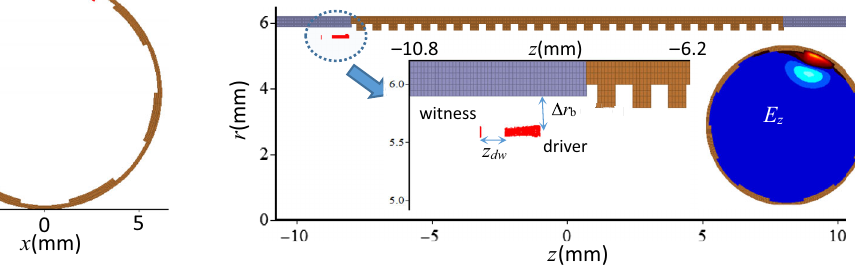
FIG. 1. (a) 3D model basic cell of the 2D periodic surface lattice generated using CST MW S tudio with the period of the lattice d z indicated, (b) photograph (left figure) of the copper, cylindrical, 2D periodic surface lattice, which single cell can be approximated by the “ square element ” shown in Fig. 1(a), with shallow sine corrugation constructed using 3D printing technique and 3D model (right figure) of the 2D PSL with shallow square wave corrugation build using 3D PiC code MAGIC , with a single cell similar to one shown in Fig. 1(a). Such a structure can be considered as a periodic composition of such elements along azimuthal ( ¯ m periods) and longitudinal coordinates. (c) Numerical model ð x; y Þ and ð r; z Þ views of the periodic structure with driver and witness bunches, the insets on the right figure are zoom-in of the driver and witness bunches and contour plot of the amplitude of the E z field component in front of the driver